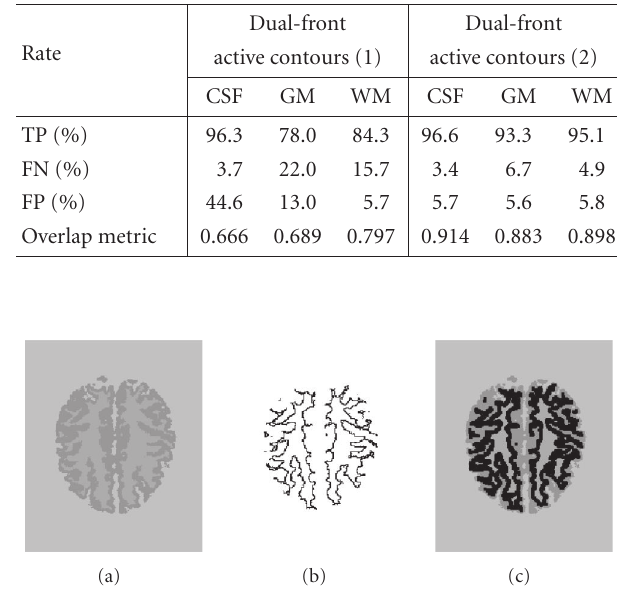
Table 1: Comparison of tissue segmentation results of our method. Dual-front active contour (1) using morphological dilation to gen- erate the active regions and (2) using histogram analysis to generate active regions.